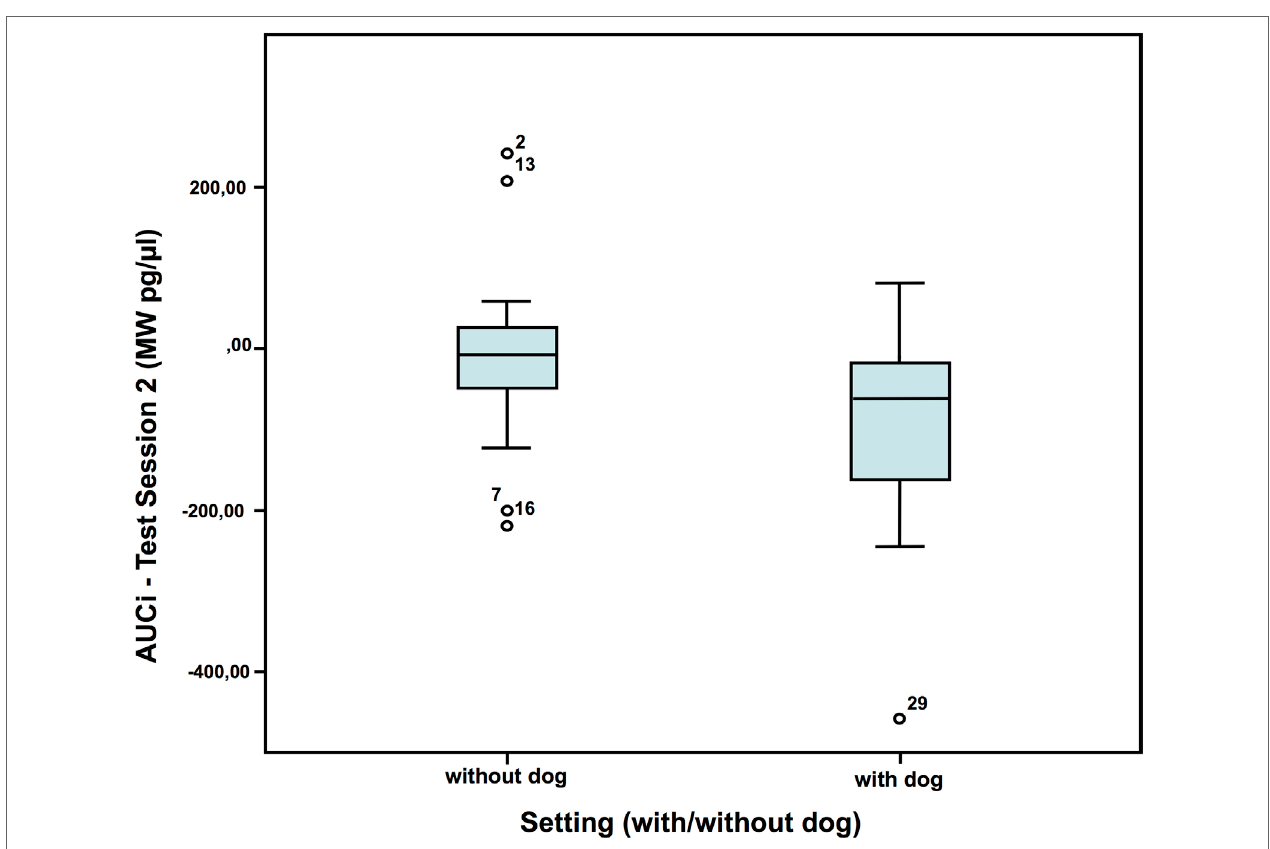
FigUre 5 | Cortisol AUCi in test session 2—comparison of the two settings